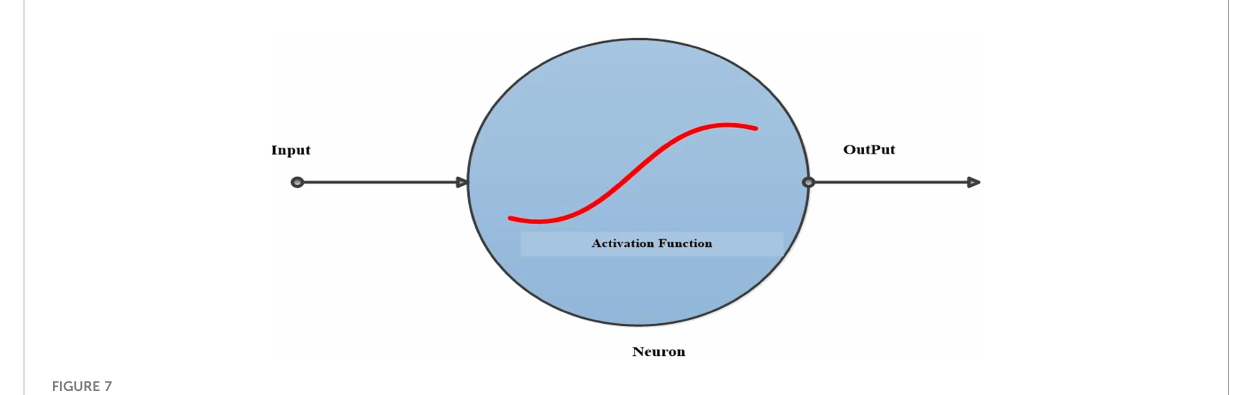
FIGURE 7 Activation function